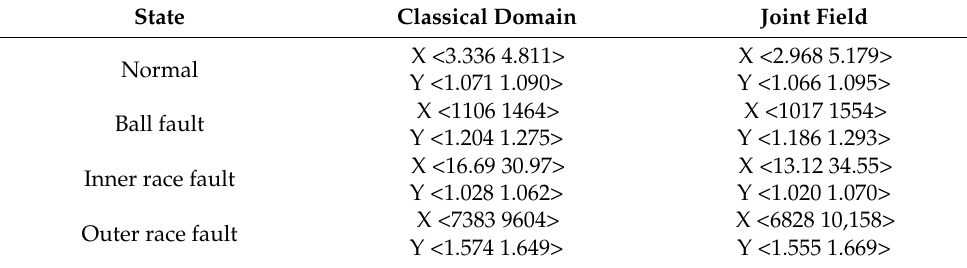
Table 4. Classical Domain and Joint Field When SPOF Diameter = 0.007 in, HP =